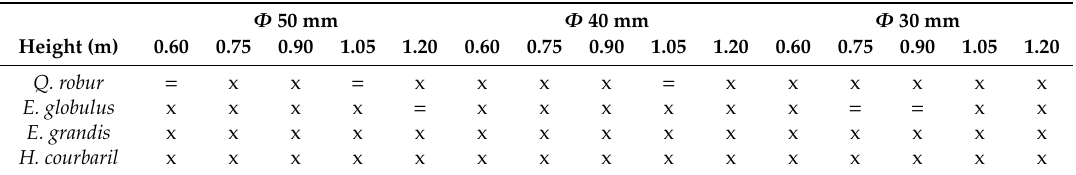
Table 4. Pairwise comparison footprint diameter (FD) of solid wood flooring (SWF) vs footprint